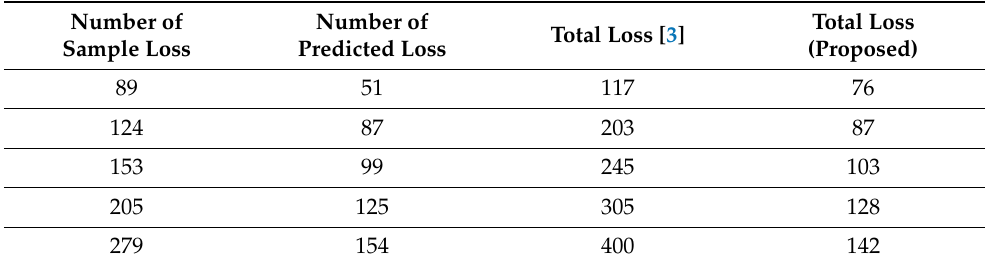
Table 8. Loss measurement